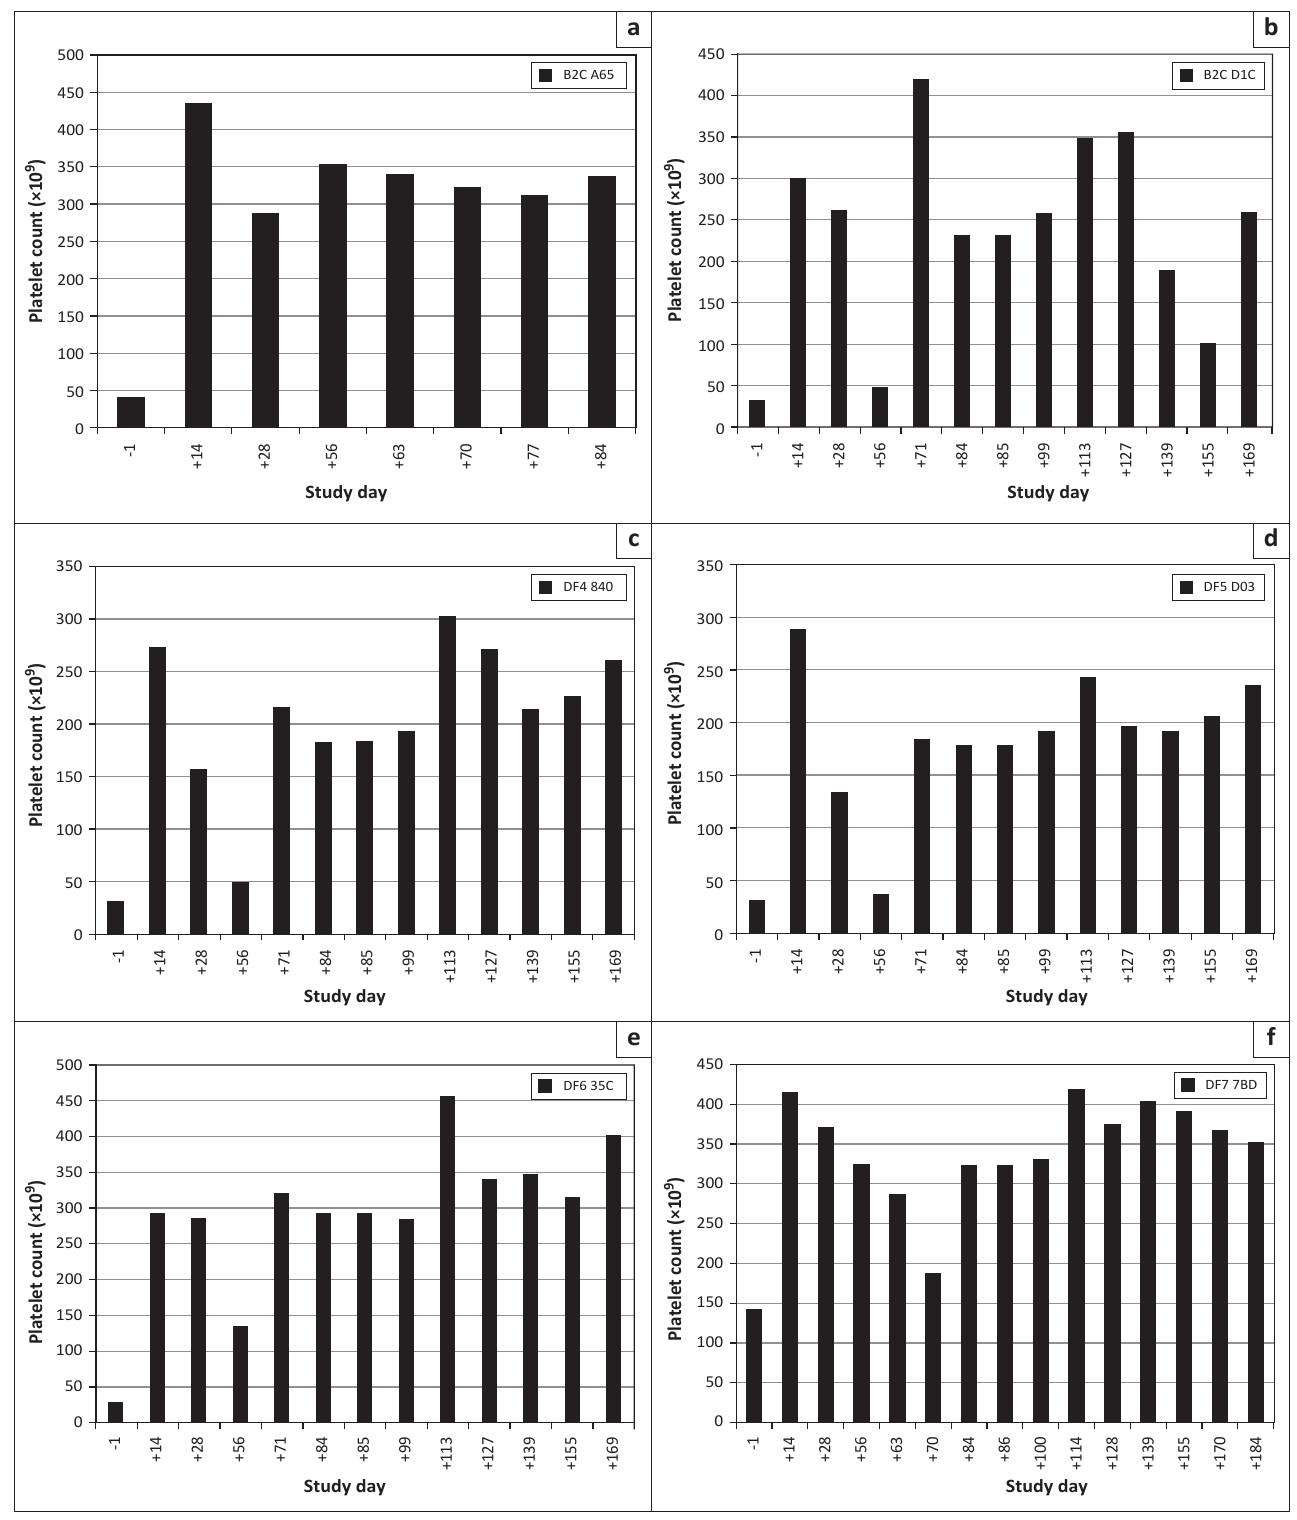
FIGURE 2: Platelet counts for the respective dogs (a–f), as determined on the study days indicated (a range of 200 x 10 9 – 500 x 10 9 is considered to be